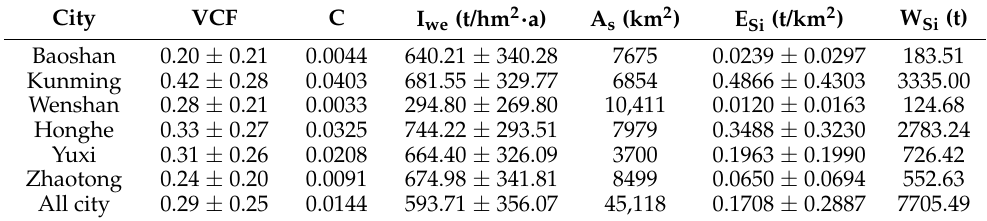
Table 3. Main calculation parameters and emissions of PM 2.5 in soil fugitive dust. City VCF C I we (t/hm 2 · a) A s (km 2